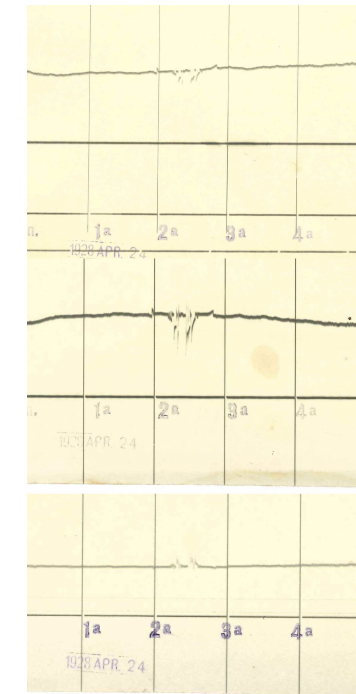
Figure 9. Potsdam Observatory photographic recordings of the hor- izontal intensity (top), declination (middle) and vertical intensity (bottom) of the time interval of 24 April 1928 at 00:00 till 24 April 1928 at 05:00 (Greenwich civil mean time), showing the disturb- ing effect of the first electrical train of the Berlin suburban railway.